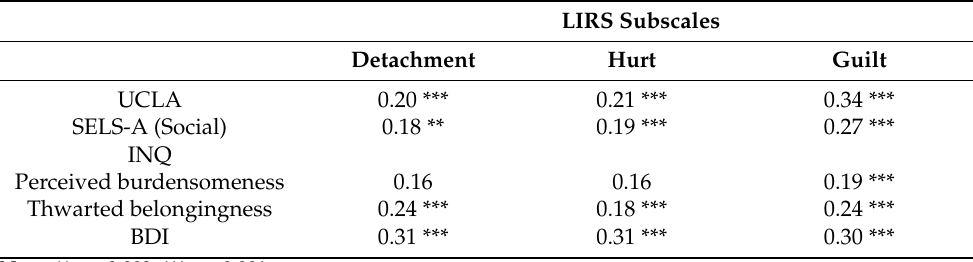
Table 6. Pearson correlations between the LIRS subscales and loneliness and depression